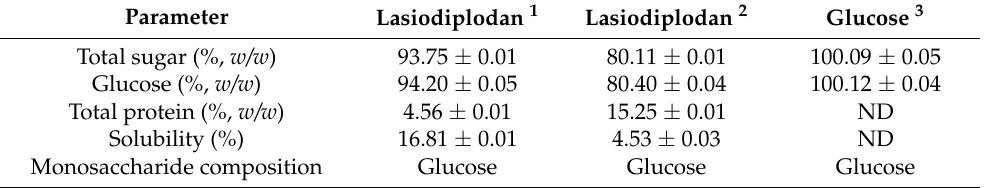
Table 2. Physicochemical characterization of lasiodiplodan from SCBCH using RBE/SBE.